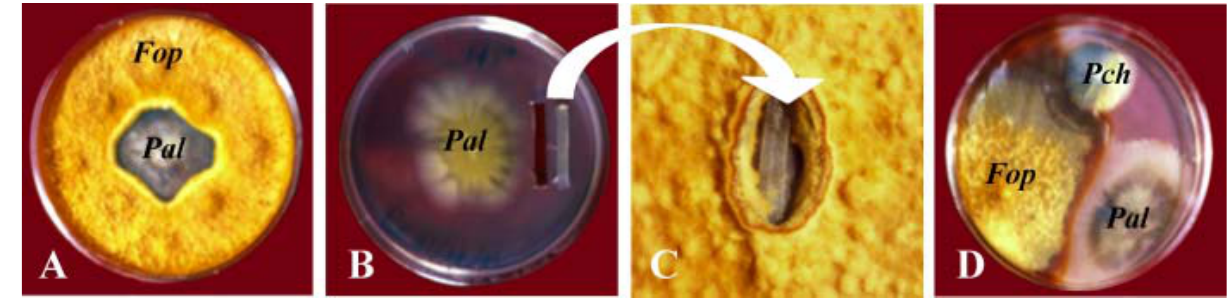
Fig. 1. Antagonism of Phaeoacremonium aleophilum ( Pal ) against Fomitiporia punctata ( Fop ): dual culture of Fo p and Pal (A); agar slice cut from the edge of a 21-day-old colony of Pal (B) and transferred to a plate inoculated with Fop (C); plates of 21-day-old triple cultures of Fop, Pal and Phaeomoniella chlamydospora ( Pch )